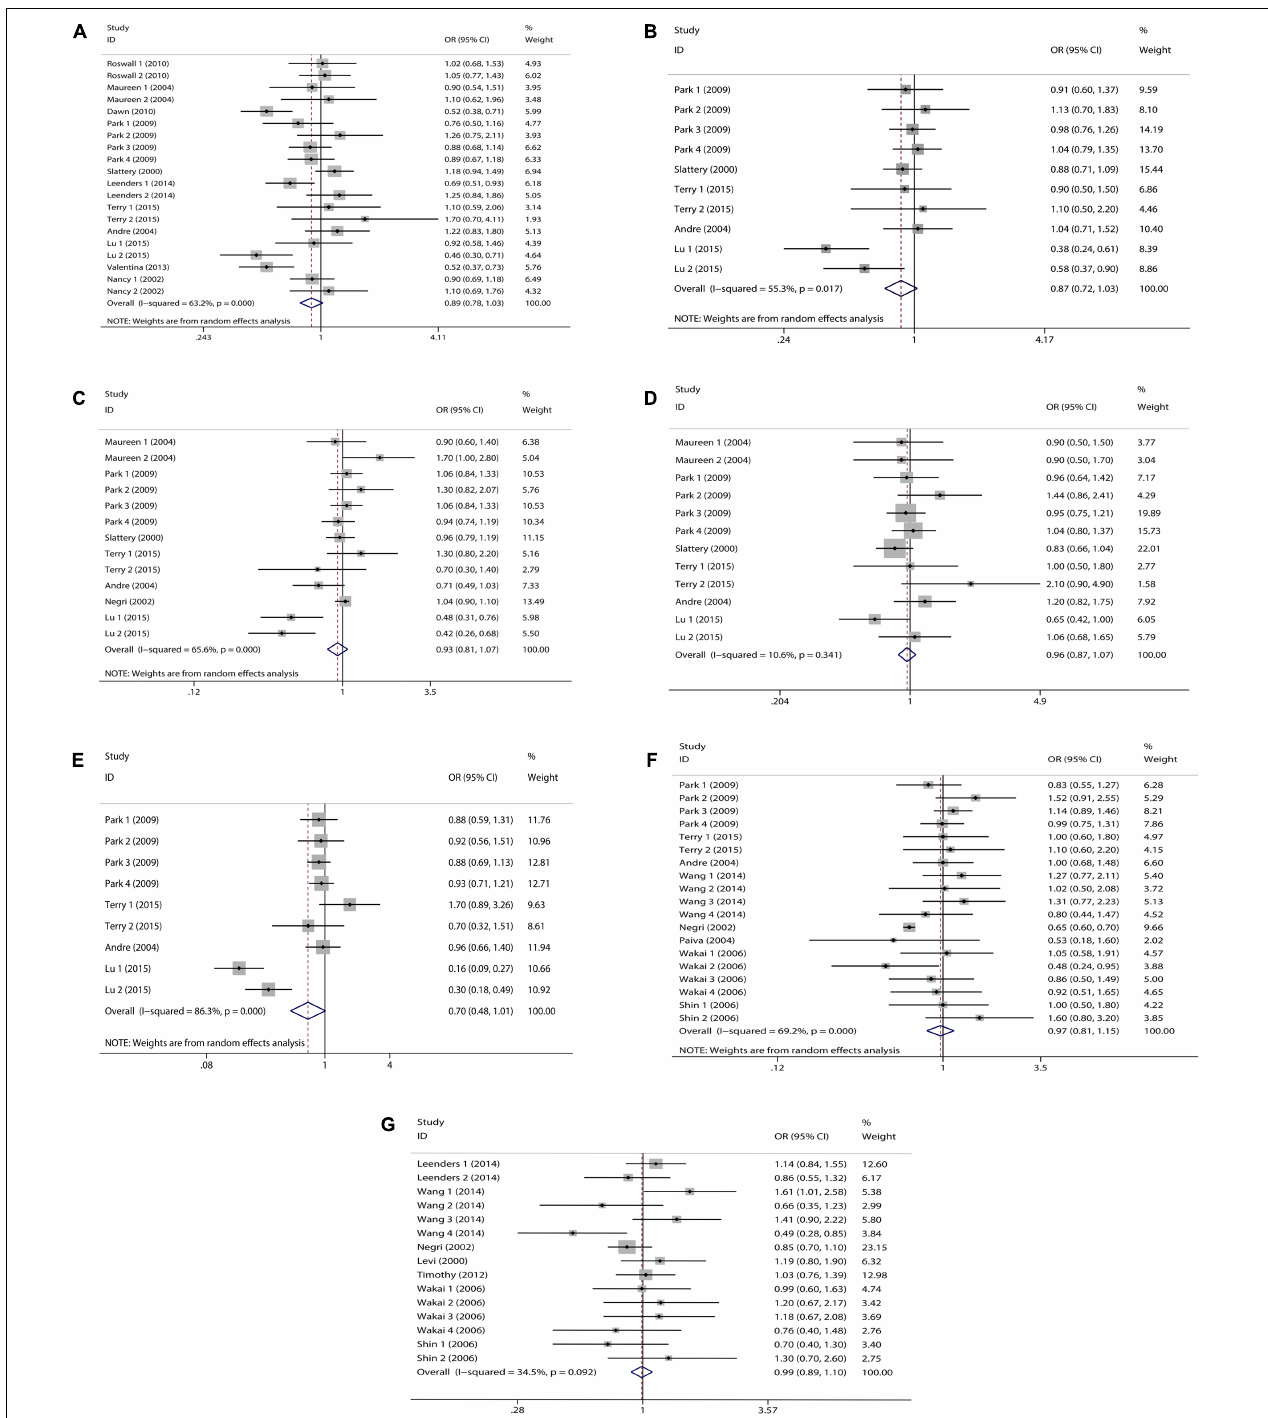
FIGURE 2 | Forest plot on dietary intake of carotenoids and retinol and colorectal cancer risk. (A) β -carotene; (B) α -carotene; (C) lycopene; (D) lutein/zeaxanthin; (E) β -Cryptoxanthin; (F) carotenoids; (G) retinol.